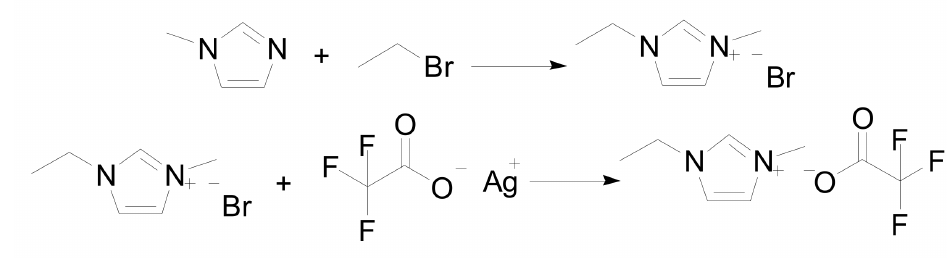
Figure 12. The preparation of [EMIM]